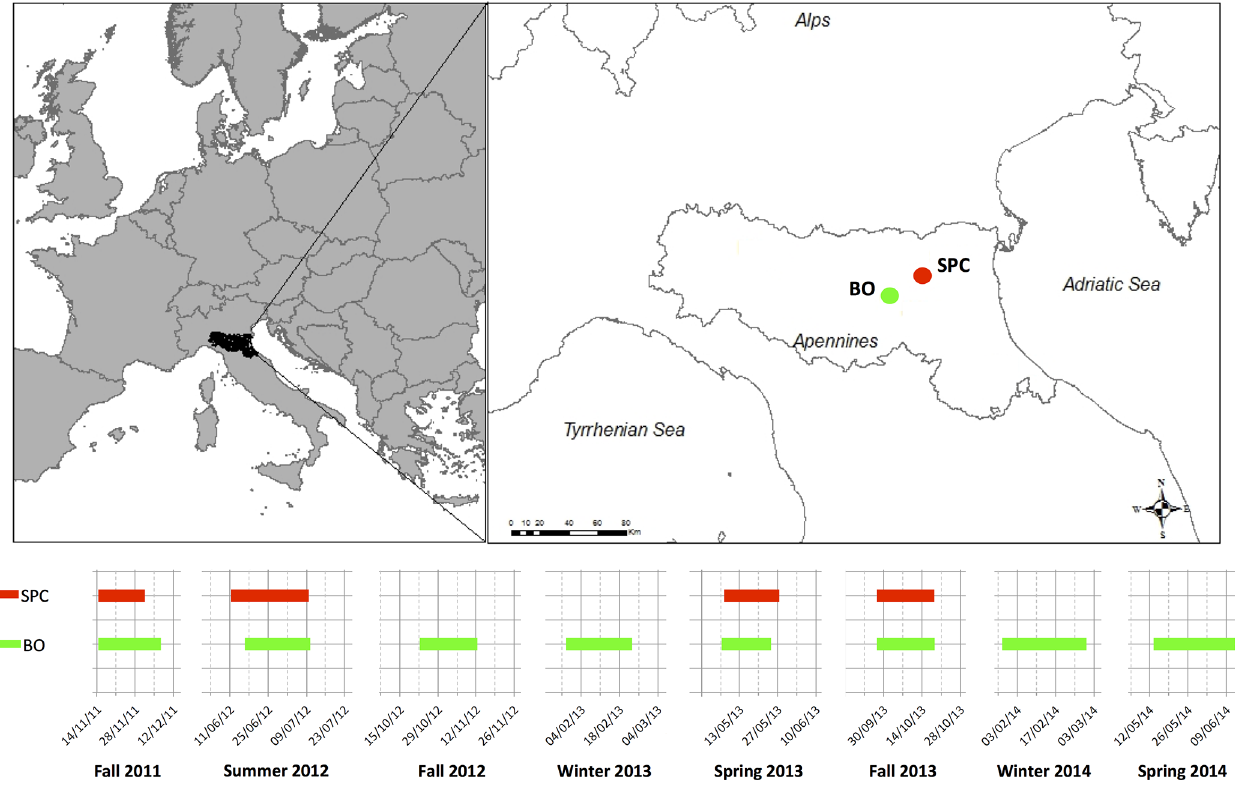
Figure 1. Supersito field campaigns: map of the sites and measurement periods considered in this